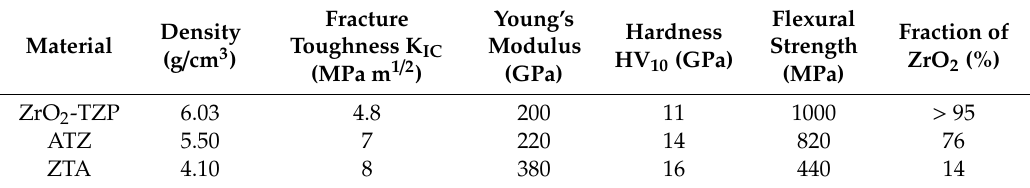
Table 1. Description of the material properties [23].